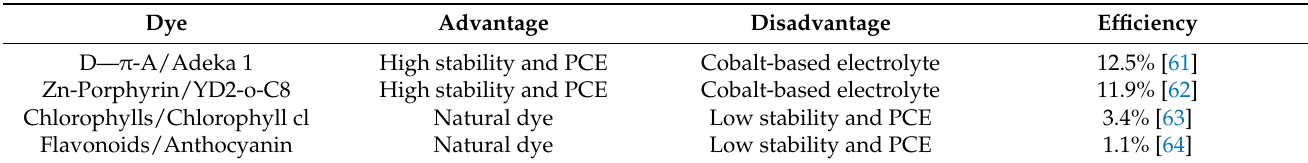
Table 3. Examples of relevant dyes in DSSC research, their advantages and disadvantages, and reported efficiencies. Dye